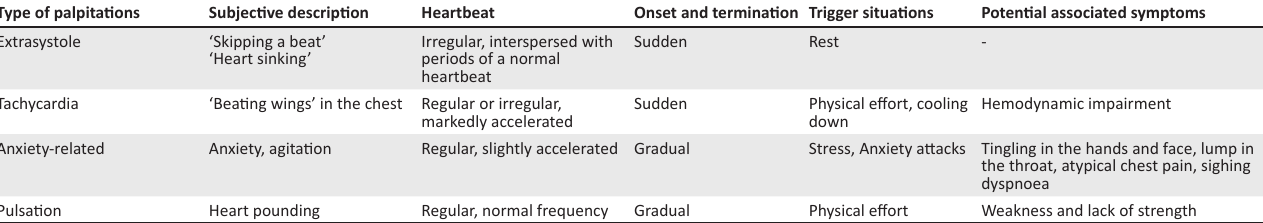
TABLE 1: Types of palpitations.